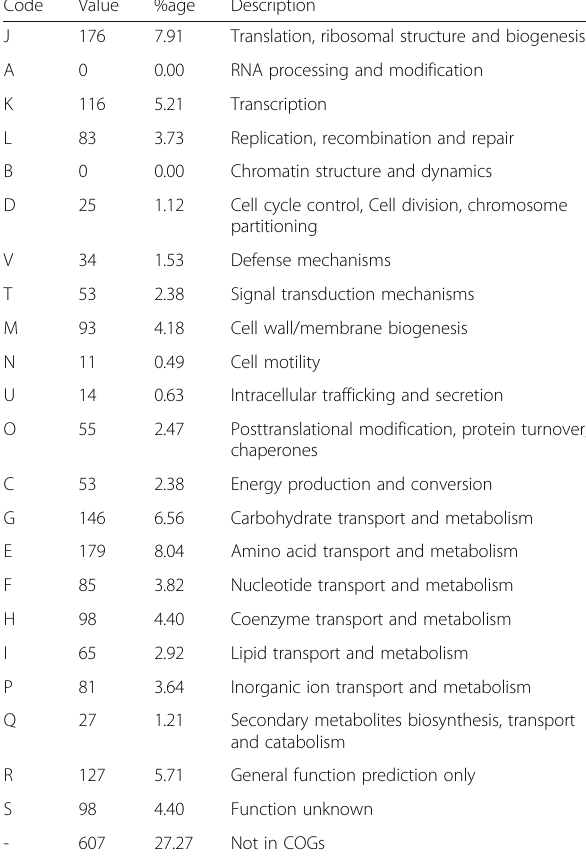
Table 5 Number of genes associated with general COG functional